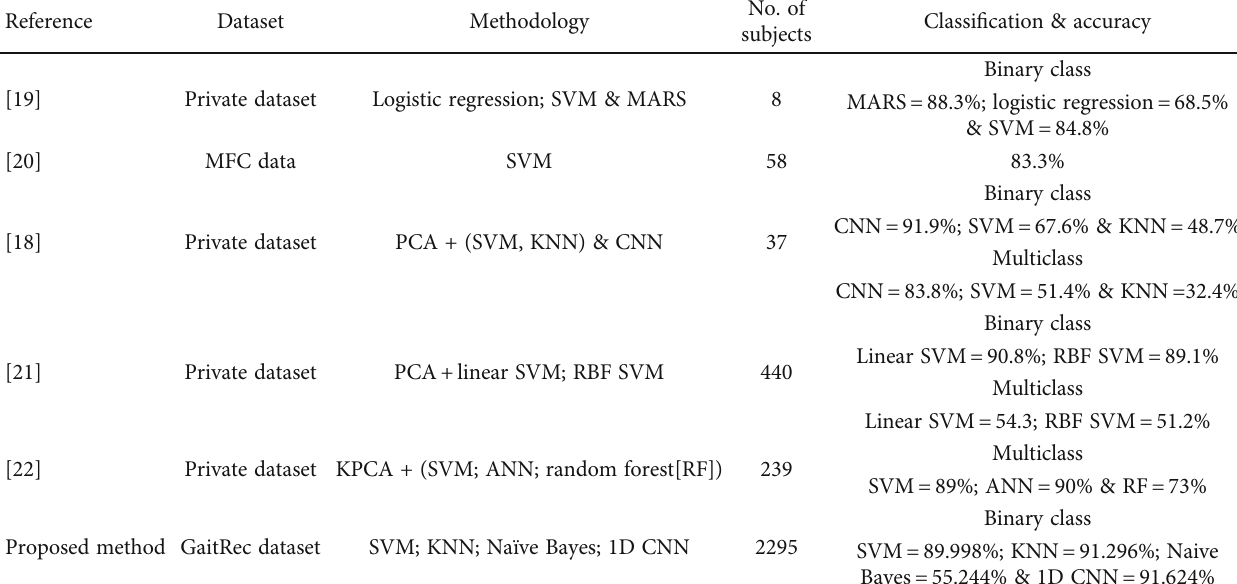
Table 9: State of the art of previous